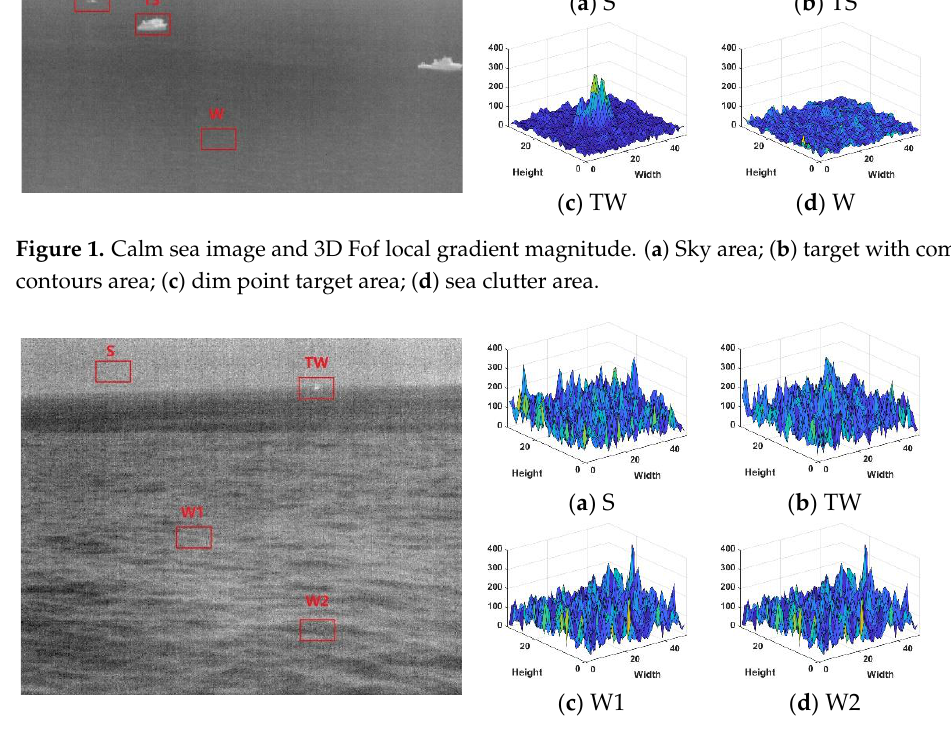
( d ) W2 Figure 3. Distribution figure of gradient values. ( a ) Sky area; ( b) dim point target area; ( c ) sea clut- ter area W1; ( d ) sea clutter area W2. Comparing the gradient amplitudes in the sea clutter area of the calm sea image and the rough sea image, it can be found that the gradient amplitude in the calm sea im- age changes gently. However, the sea surface area of the rough sea image has richer tex- ture information and more significant fluctuation of the gray value. 2.2. Orientation Texture Feature of Target From Section 2.1, it can be seen that the gradient magnitude of the target has a strong saliency. We will draw the gradient vector image of the typical local area to ana- lyze the directional features of texture information. As seen in Figure 4, the target contour in the calm sea image has texture ductility in multiple directions, showing strong continuity. However, the gradient vector changes in the background region are disordered. The rough sea image target is mainly disturbed by strong sea clutter. The sea clutter has ductility in the horizontal direction, and the target is generally a divergent point. Therefore, the gradient images in four directions of horizontal, vertical, 45 , and 135